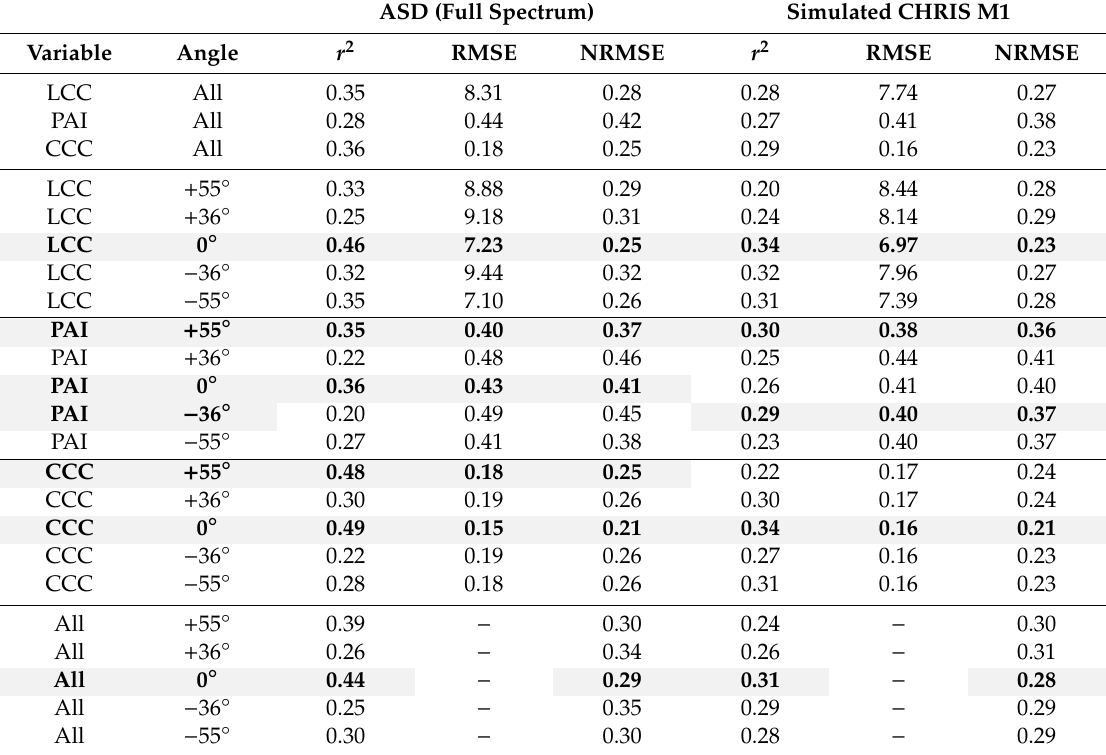
Table 7. PROSAIL LM model performance for plot scale data averaged over all sites and VZAs. RMSE units: LCC ( µ g / cm 2 ); PAI (unitless); CCC (g / m 2 ). NRMSE = RMSE / range of measured data. The top angle-based results are highlighted and bolded.